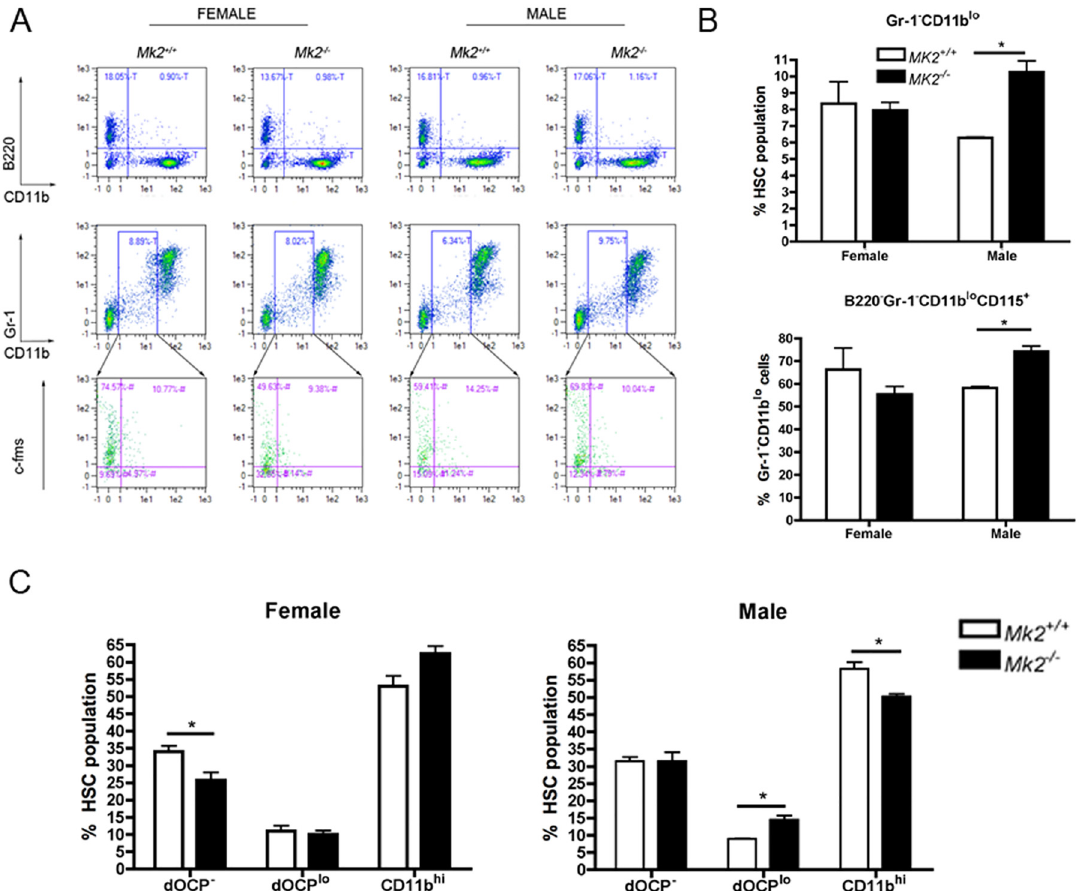
Fig 2. Ablation of MK2 increases dOCP lo cells in male mice, but not female mice. (A) Representative flow cytometry of bone marrow from male and female Mk2 +/+ and Mk2 -/- mice. (B) Enumeration of Gr-1 - CD11b lo cells as a percent of the hematopoietic stem cell population (HSC, top) and CD115+ as a percent of Gr-1 - CD11b lo cells (bottom). (C) Enumeration of CD11b surface expression in female (left) and male (right) mouse bone marrow cells. Data are expressed as means ± SE compared to Mk2 +/+ controls ( * P (cid:1) 0.05).